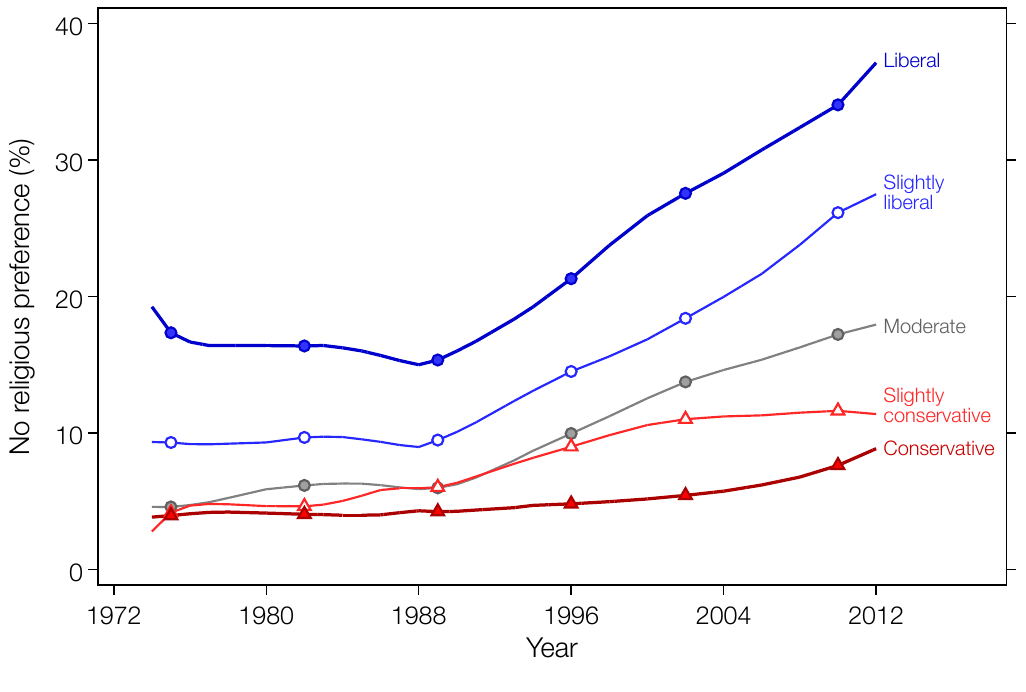
Figure 2: No Religious Preference (percent) by Year and Political Views: Adults, United States,